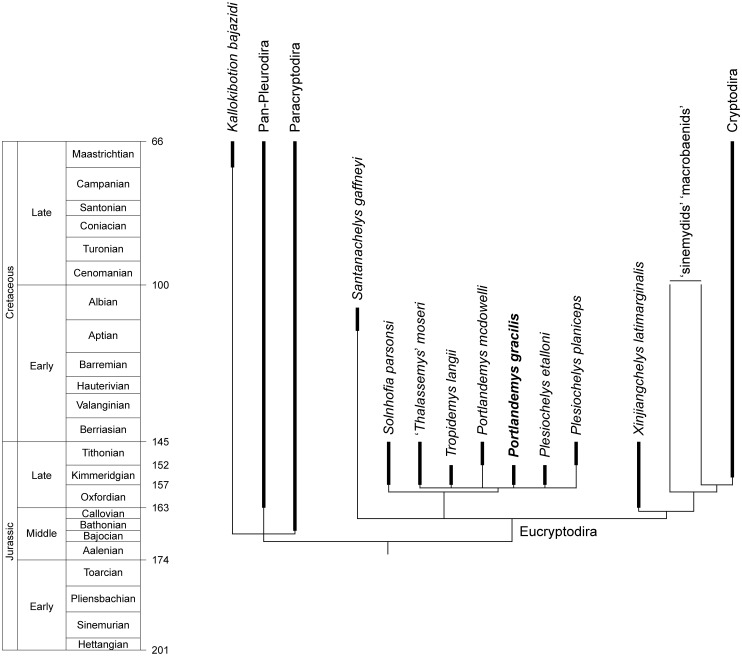
Phylogenetic relationships of plesiochelyid turtles.Partial version of the strict consensus of 180 Wagner trees (see S1 File for complete tree).